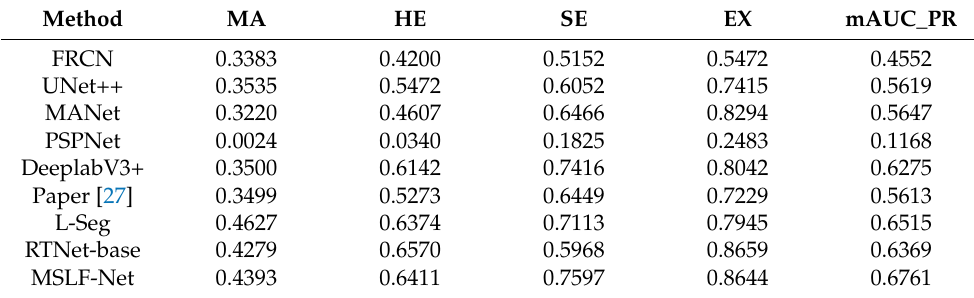
Table 2. Comparison experiments based on IDRID.